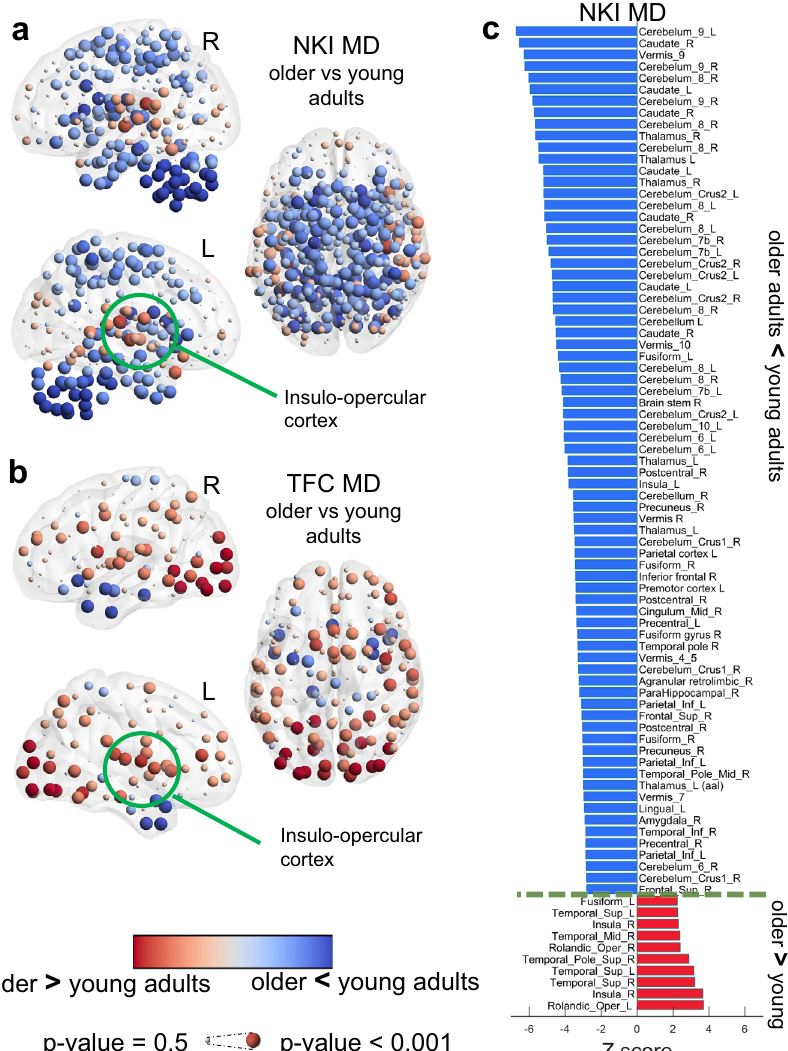
Fig. 5 Age effects of modular dissociation (MD). a Age differences in MD within the Nathan Kline Institute (NKI) cohort, older adults (OA) compared with young adults (YA). b Age differences in MD within The 1000 functional connectome (TFC) cohort OA compared with YA. c Signi fi cant brain regions for the NKI-MD comparison; corrected at p -value < 0.05. Differences were assessed with non-parametric permutations (5000) after regressing covariates of no interest. Regions ’ names are given using the Automatic Anatomical Labelling